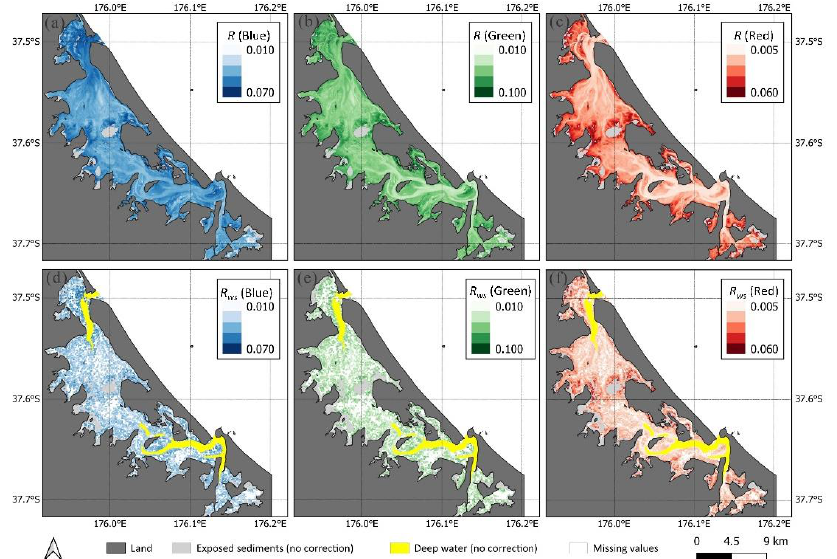
Figure 10. Maps of blue, green and red band reflectance in inundated regions before ( a – c ) and after ( d – f ) correction using the spatial method (with a 60-m tile size). The reflectance before correction was derived from the Sentinel-2 image on 5 February 2019 at high tide. Reflectance in emerged (exposed sediment) regions and optically deep channels did not need correction, which are marked in grey and yellow, respectively. The missing values due to nonuniform input data are marked in white.